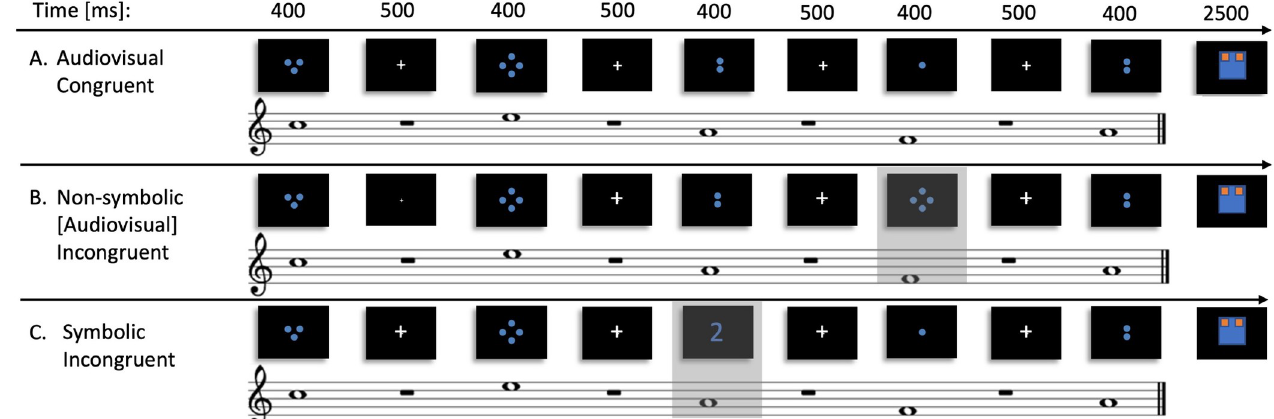
Fig 1. Illustration of the design. Example of congruent and incongruent trials. A: Audiovisual congruent trial was based on the explicit rule “the higher the pitch of the tone, the larger the cardinality of the figure” B: Audiovisual incongruent trial contained an incongruent stimulus with respect to the learned rule. C: Symbolic incongruent trial contained visual stimulus in which cardinality was presented through symbol (Arabic digit).